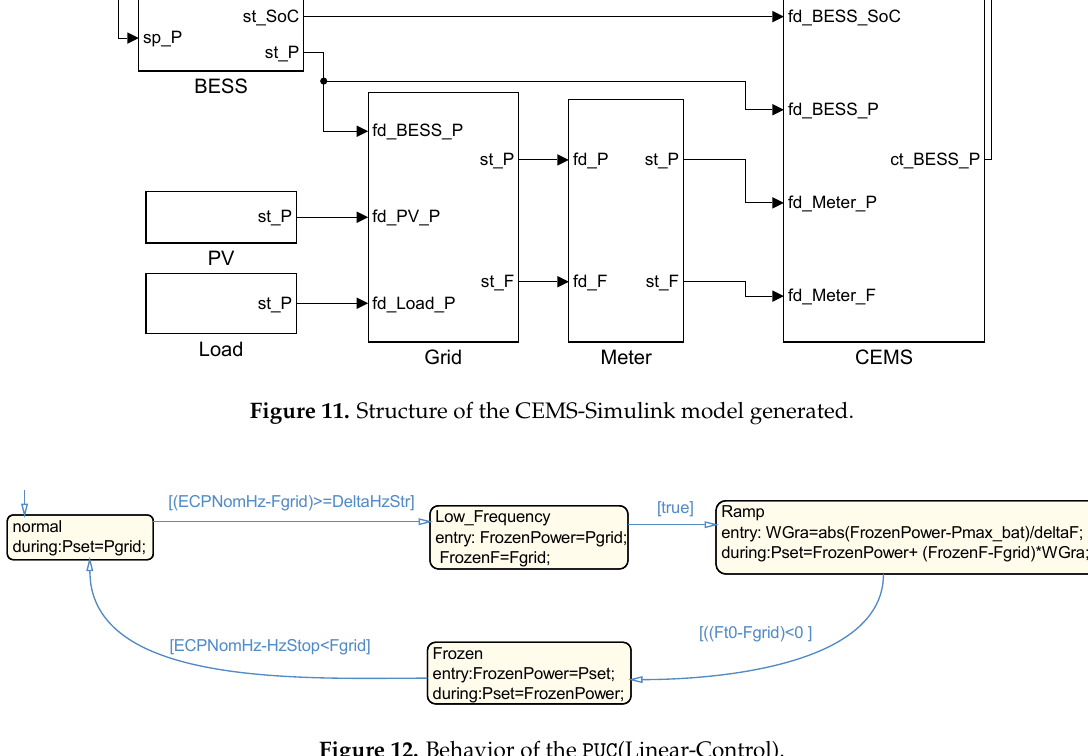
Figure 12. Behavior of the PUC